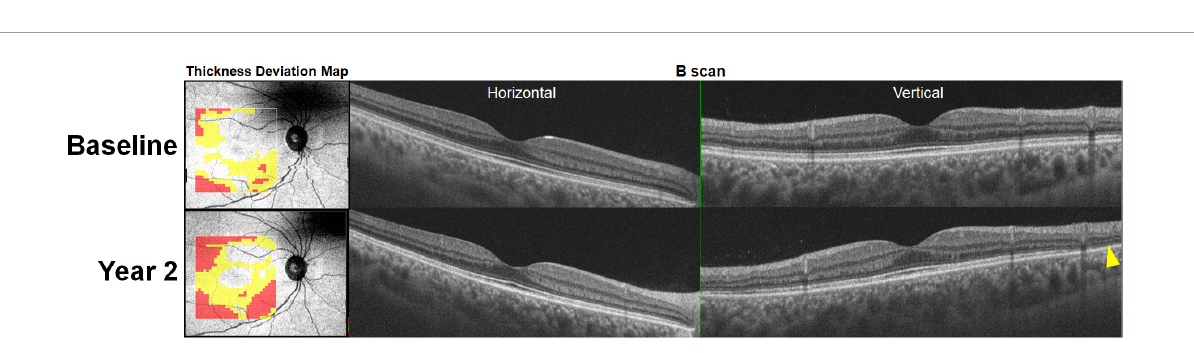
FIGURE4 Retinal thinning noted on optical coherence tomography (OCT) retinal thickness deviation maps (left) at baseline (hydroxychloroquine [200 mg/day] use for 8 years) prior to the development of recognizable photoreceptor defects (yellow arrowhead) on OCT B-scan images noted 2 years later. At the follow-up visit, the thickness deviation map indicates more extensive retinal thinning in the inferior